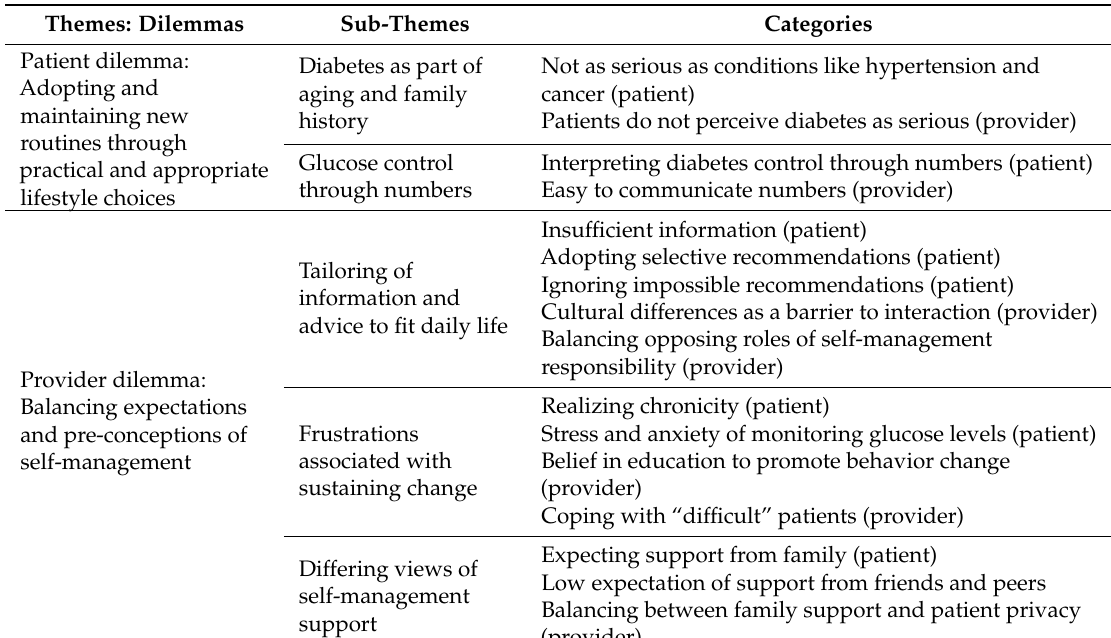
Table 3. Results from participant